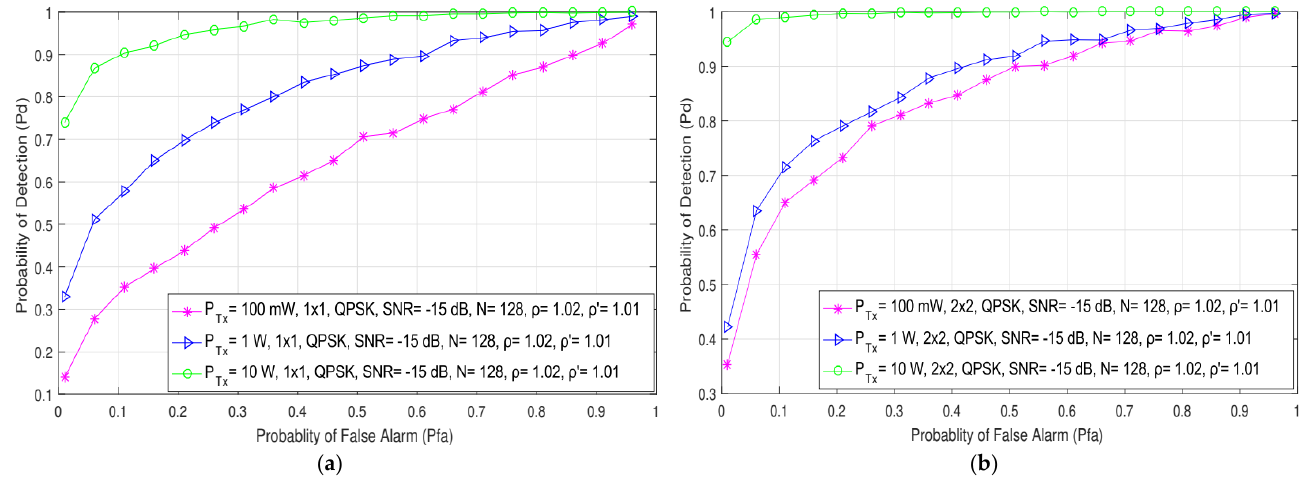
Figure 3. The ROC curves presenting the ED performance for the different PU Tx powers and an SNR of − 15 dB in ( a ) SISO and ( b ) 2 × 2 MIMO communication systems.